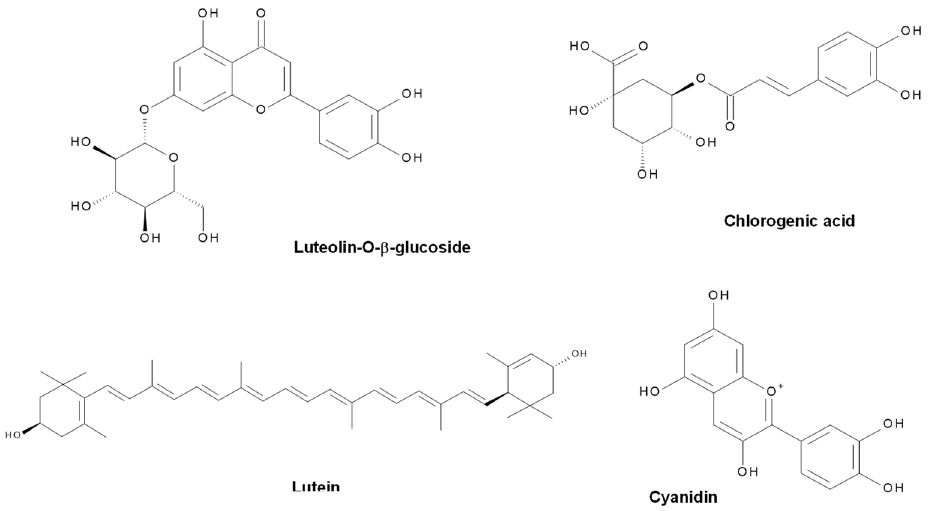
Figure 13. Chemical structure of some of the main components of Chrysanthemum morifolium extract.